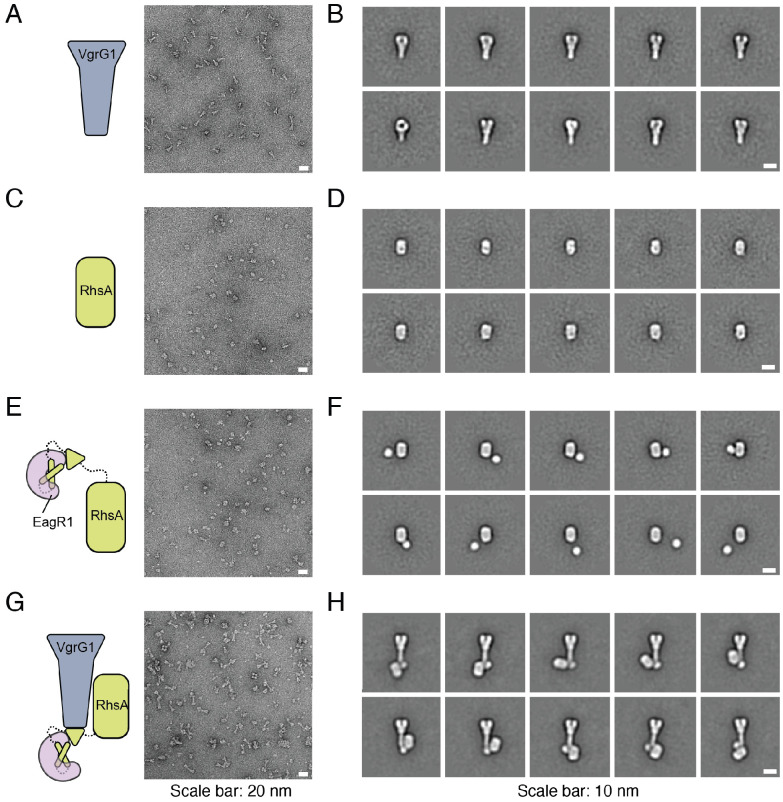
RhsA, EagR1, and VgrG1 form a ternary complex in vitro.Unprocessed micrographs (A, C, E, G) and representative 2-D class averages (B, D, F, H) of negatively stained VgrG1 (A, B), RhsA∆NT (C, D), EagR1-RhsA complex (E, F) and EagR1-RhsA-VgrG1 complex (G, H). Scale bar represents 20 nm for unprocessed micrographs and 10 nm for class averages.